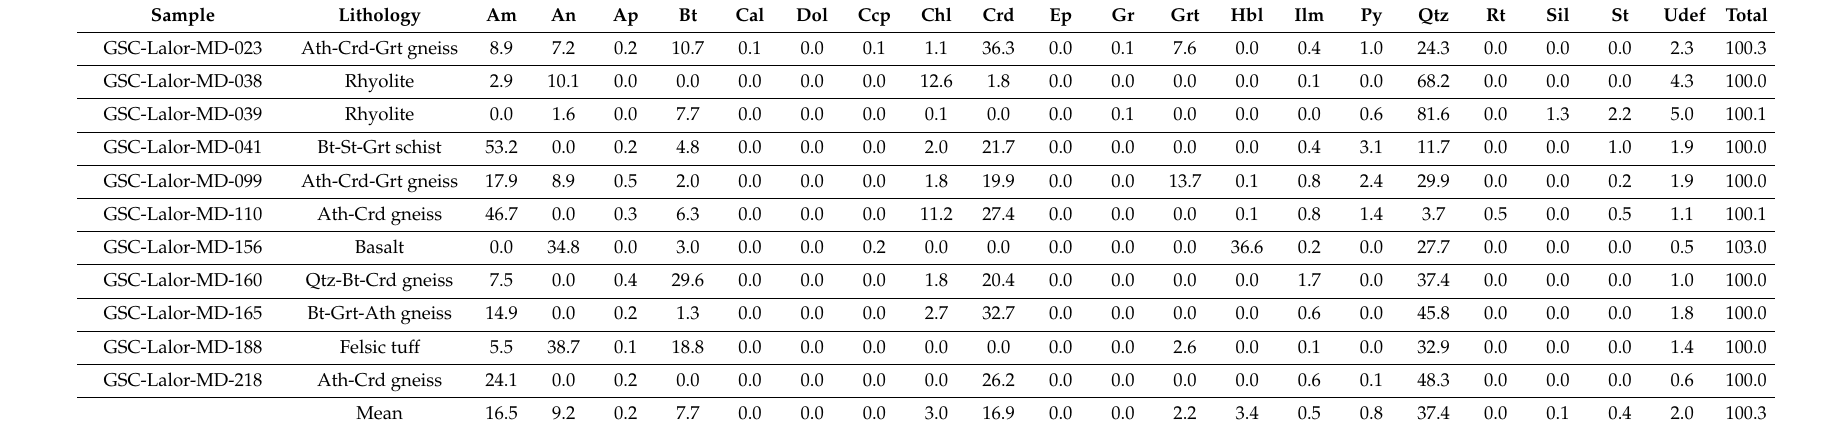
Table 3. SEM-EDS analyses listing identified and classified minerals in